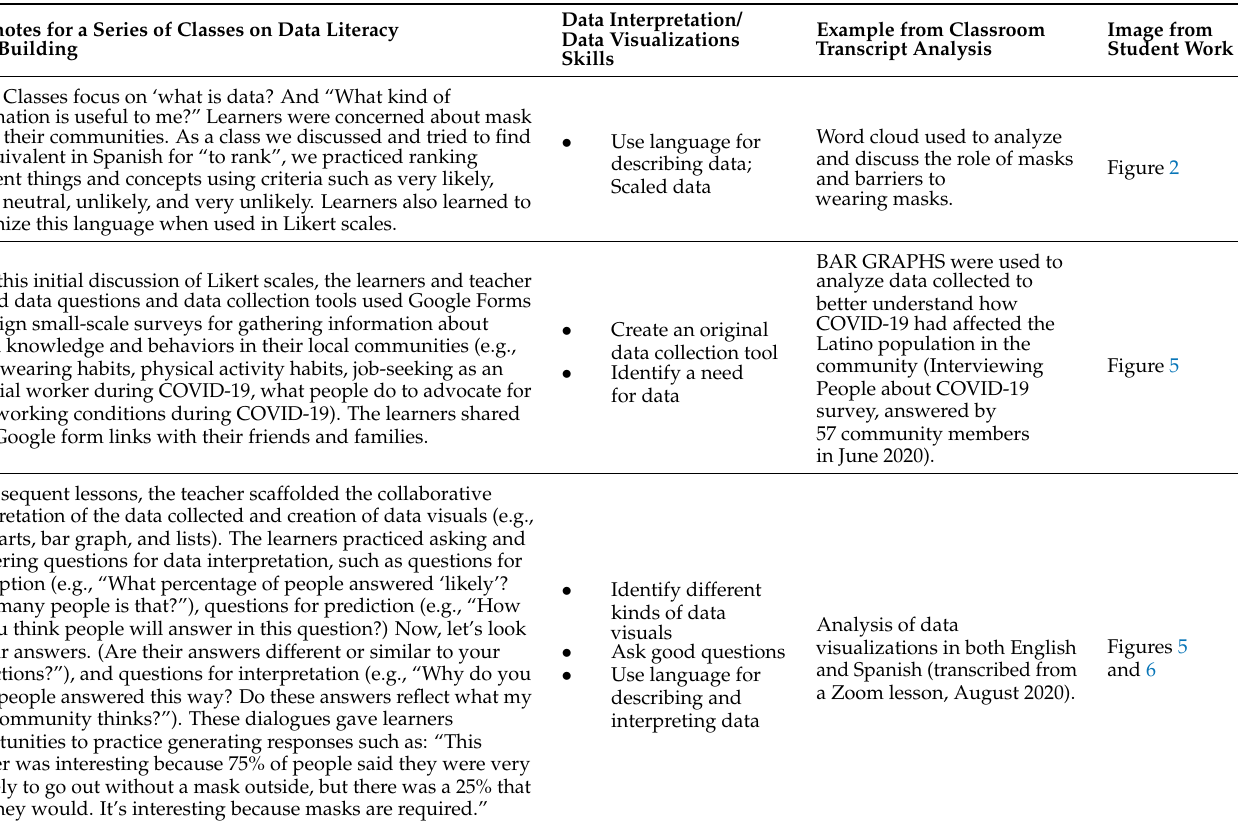
Table 2. Teaching field notes and examples from the data literacy skill-building activities related to COVID-19 themes, annotated to highlight relevant data interpretation and data visualization skills at work in the